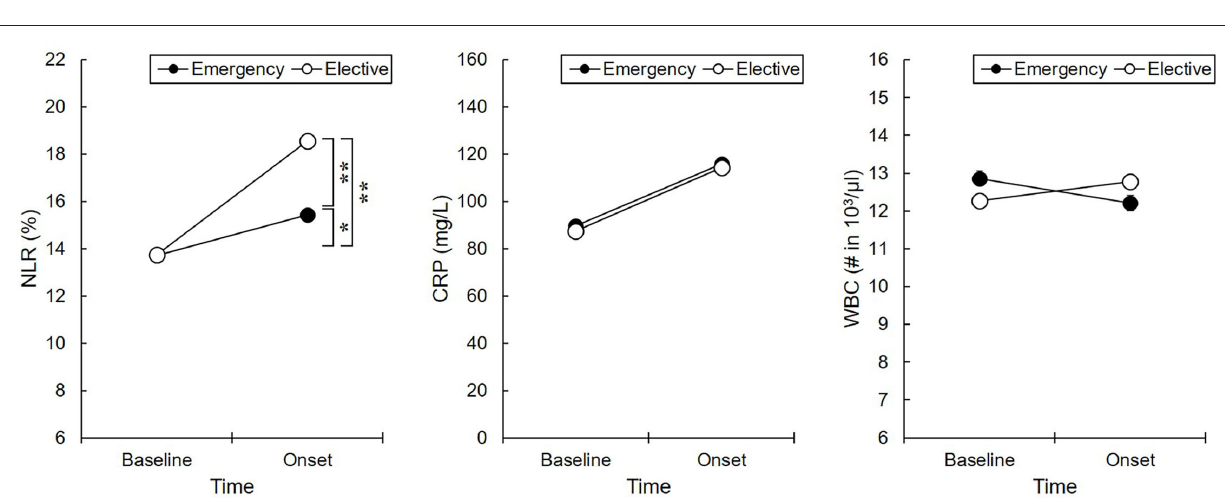
FIGURE 3 | Inflammatory responses between delirium subtypes. * p < 0.05, ** p < 0.01, *** p < 0.001. Non-hypoactive, non-hypoactive motor subtype; Hypoactive, hypoactive motor subtype; Baseline, the initial day of intensive care unit admission; Onset, the initial day of delirium onset; NLR, neutrophil-lymphocyte ratio; CRP, C-reactive protein; WBC, white blood cell. The CRP level in the non-hypoactive group was significantly increased than that in the hypoactive group during delirium onset.